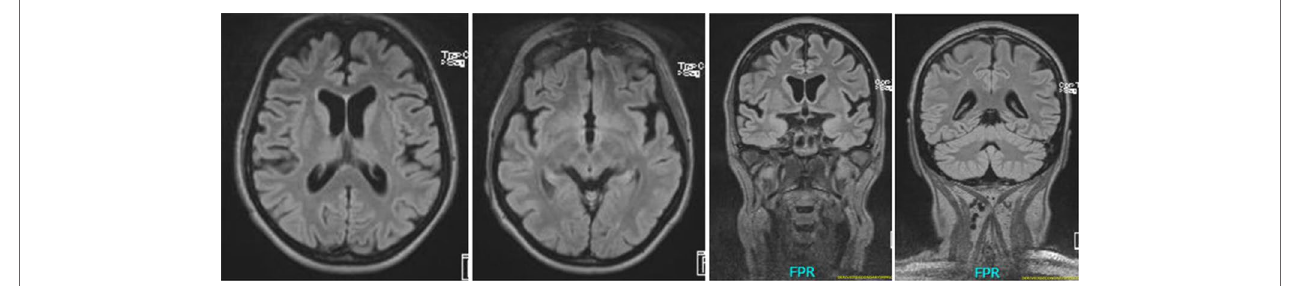
FIGURE 1 | Cerebral magnetic resonance (cMRI) imaging showing generalized atrophy with perisylvian